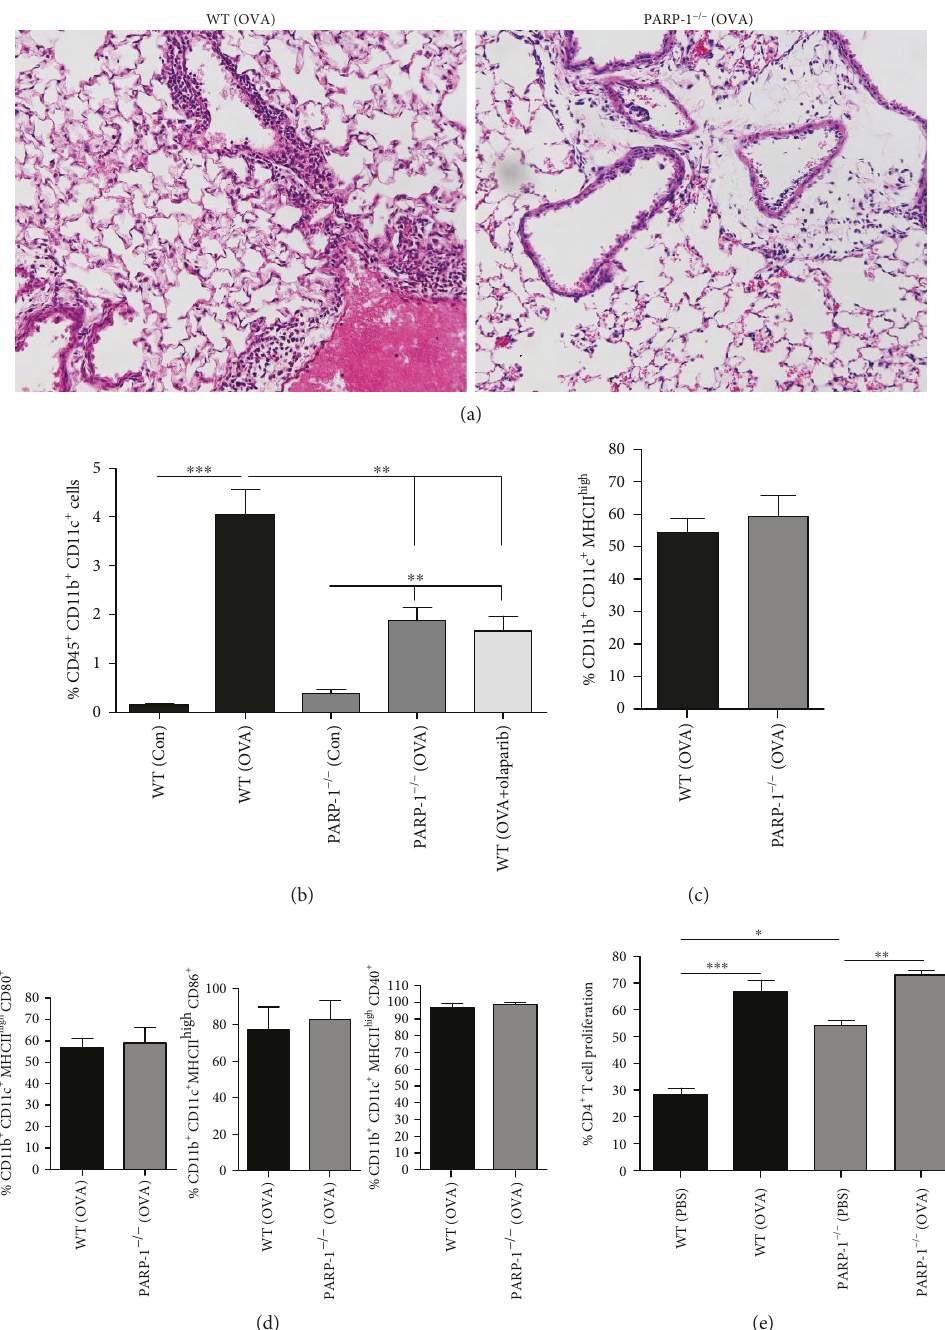
Figure 3: WT or PARP-1 − / − mice were subjected to OVA sensitization followed by a single challenge or left unchallenged. A group of mice received olaparib (5 mg/kg) 30 minutes post-OVA challenge. Mice were sacri fi ced 48h later. Lungs from the di ff erent experimental groups were fi xed with formalin or processed to generate single-cell suspensions. (a) Lung sections were stained with hematoxylin and eosin; bar: 50 μ m. (b) Cells were stained with a combination of antibodies to CD45, CD11b, and CD11c. CD11b + /CD11c + cell population was gated from the live CD45 + population. (c) WT or PARP-1 − / − mice were sensitized twice with OVA; spleens and lymph nodes were then collected 6 hours after the last sensitization and processed for single-cell suspensions. Cells were then stained with a combination of antibodies to CD11b, CD11c, and MHC. (d) Percentage of CD11b + /CD11c + /MHCII high DCs that express CD80, CD86, or CD40. (e) Sorted CD11c + /CD11b + /MHCII high cells from OVA-sensitized WT or PARP-1 − / − mice were pulsed with OVA 323-339 peptide or vehicle overnight, washed, and then cocultured with CFSE-stained CD4 + T cells from OTII mice for four days. Proliferation was assessed by fl ow cytometry. For (a, b) and (d – h), the results are expressed as mean ± SD ; ∗ p ≤ 0 05 ; ∗∗ p ≤ 0 01 ; ∗∗∗ p ≤ 0 001